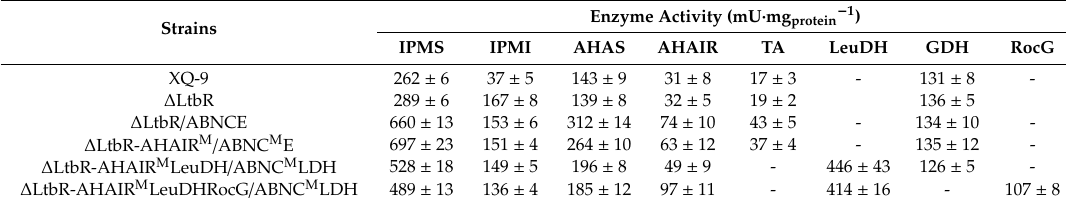
Table 1. Enzyme activities for the l -leucine biosynthesis by C. glutamicum strains.